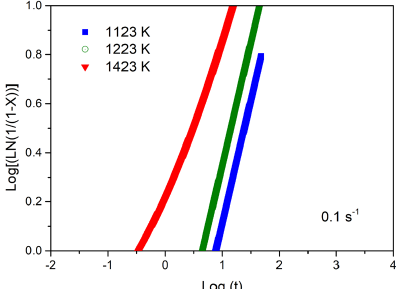
Figure 11. JMAK plot for 18MnCrSiMo6-4 during the hot compression showing the effect of the temperature in the softening